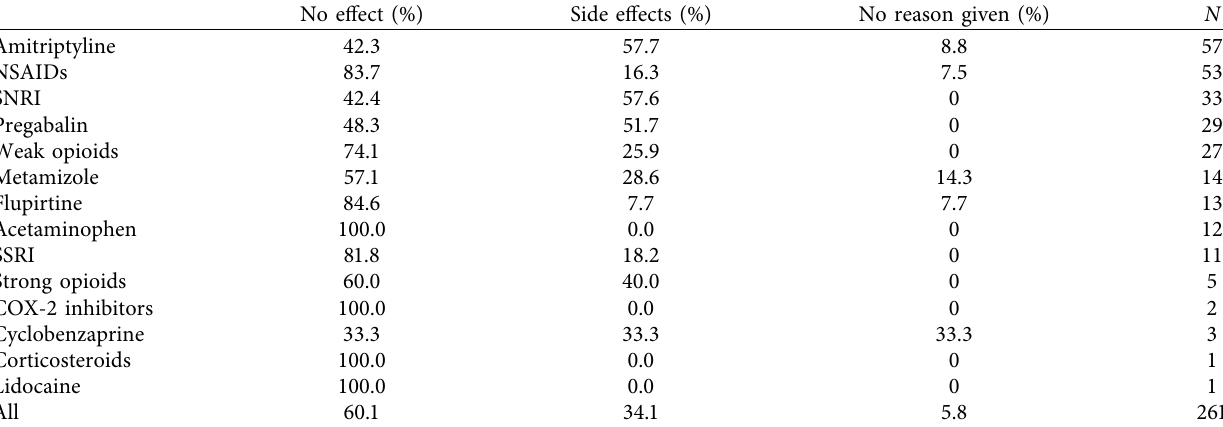
N , the total number of treatments with the respective drug in the past.